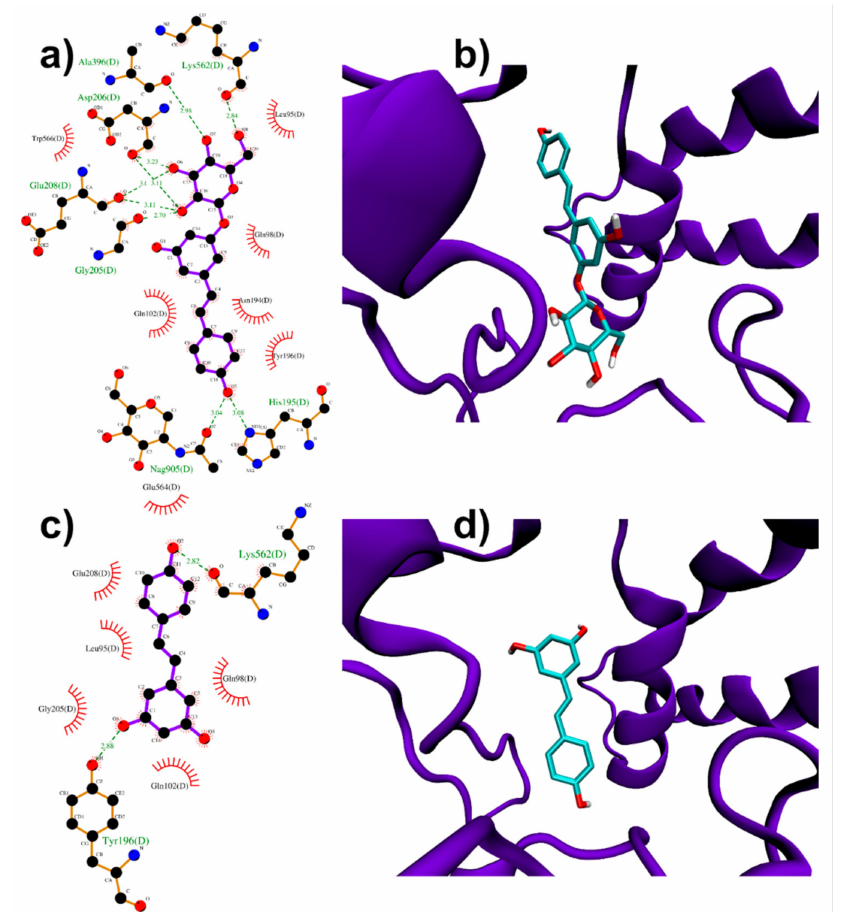
Figure 3. PD ( a , b ) and RESV ( c , d ) top-ranked poses docked to